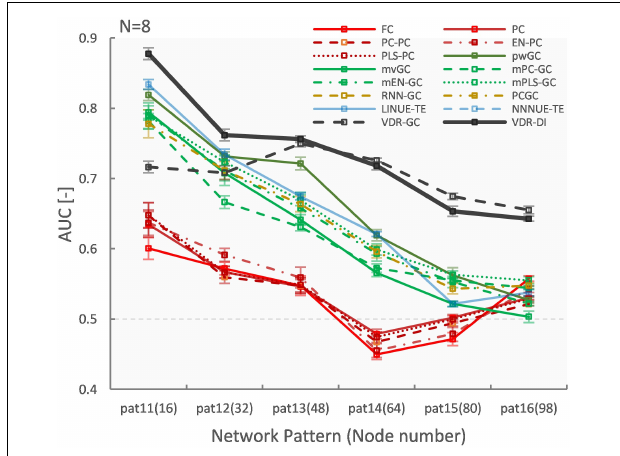
FIGURE 7 | Node number (fully connected) vs. AUC result.